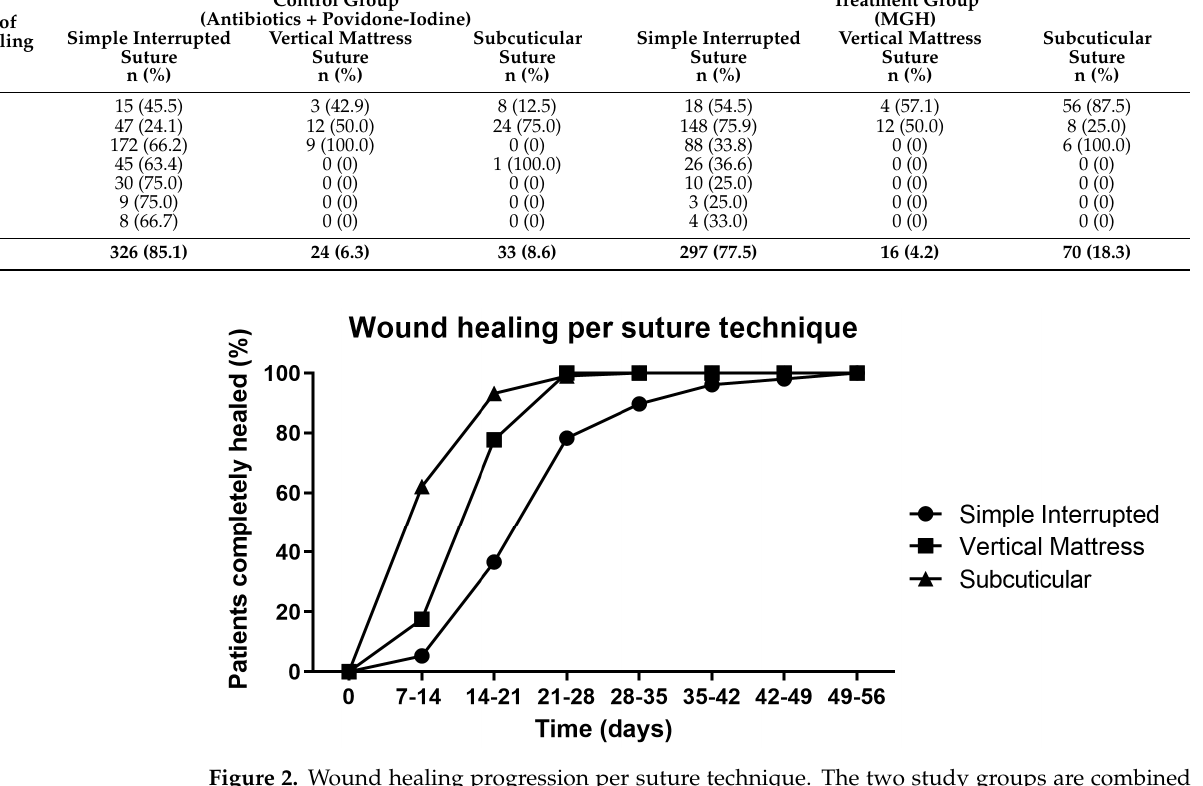
Figure 2. Wound healing progression per suture technique. The two study groups are combined because there was no significant association between the study group and the risk of complications.